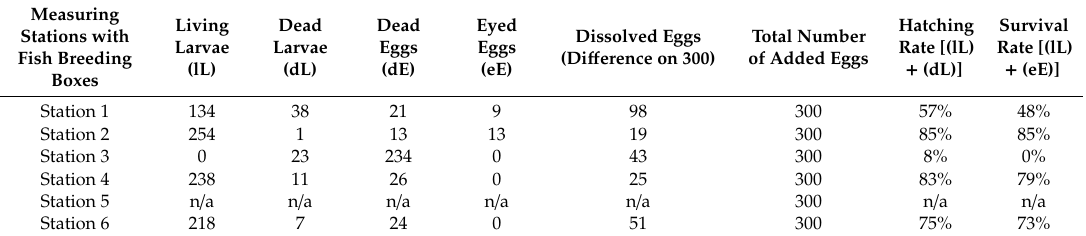
Table 2. Summary of the fish breeding box results at the six monitoring stations (n / a: not available). Measuring Stations with